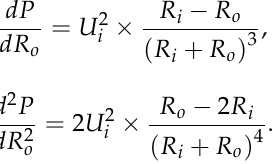
Figure 9. The features of dP/dU variation of P ‐ U characteristics of the photovoltaic cells. (